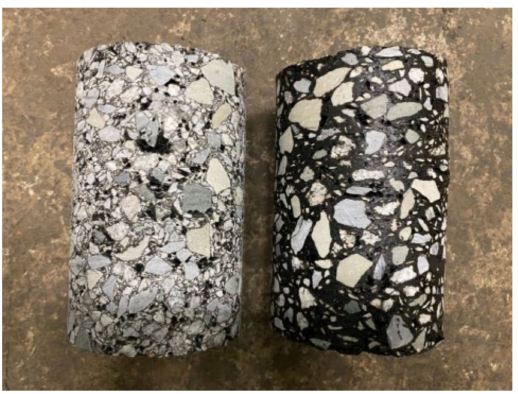
Figure 5. Specimen after short-term aging ( left ) and specimen after long-term aging ( right